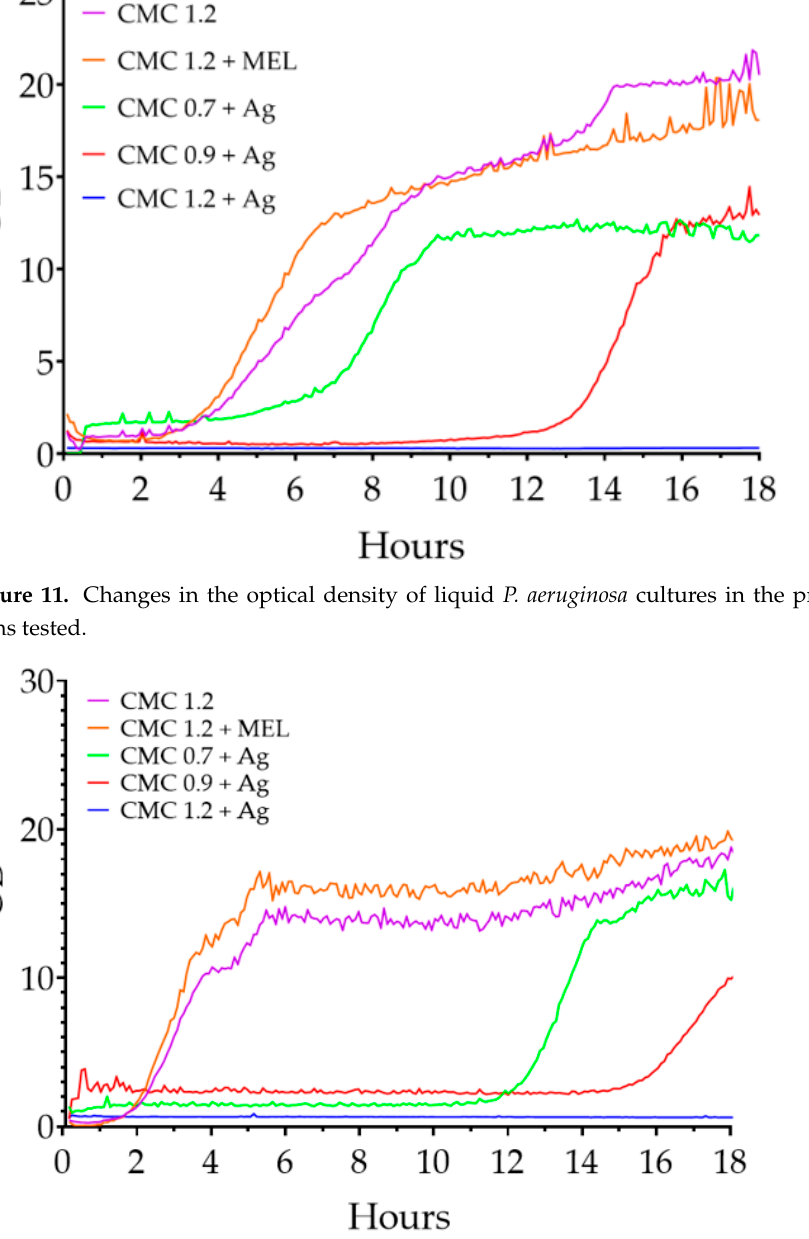
Figure 12. Changes in the optical density of liquid B. cereus cultures in the presence of the films